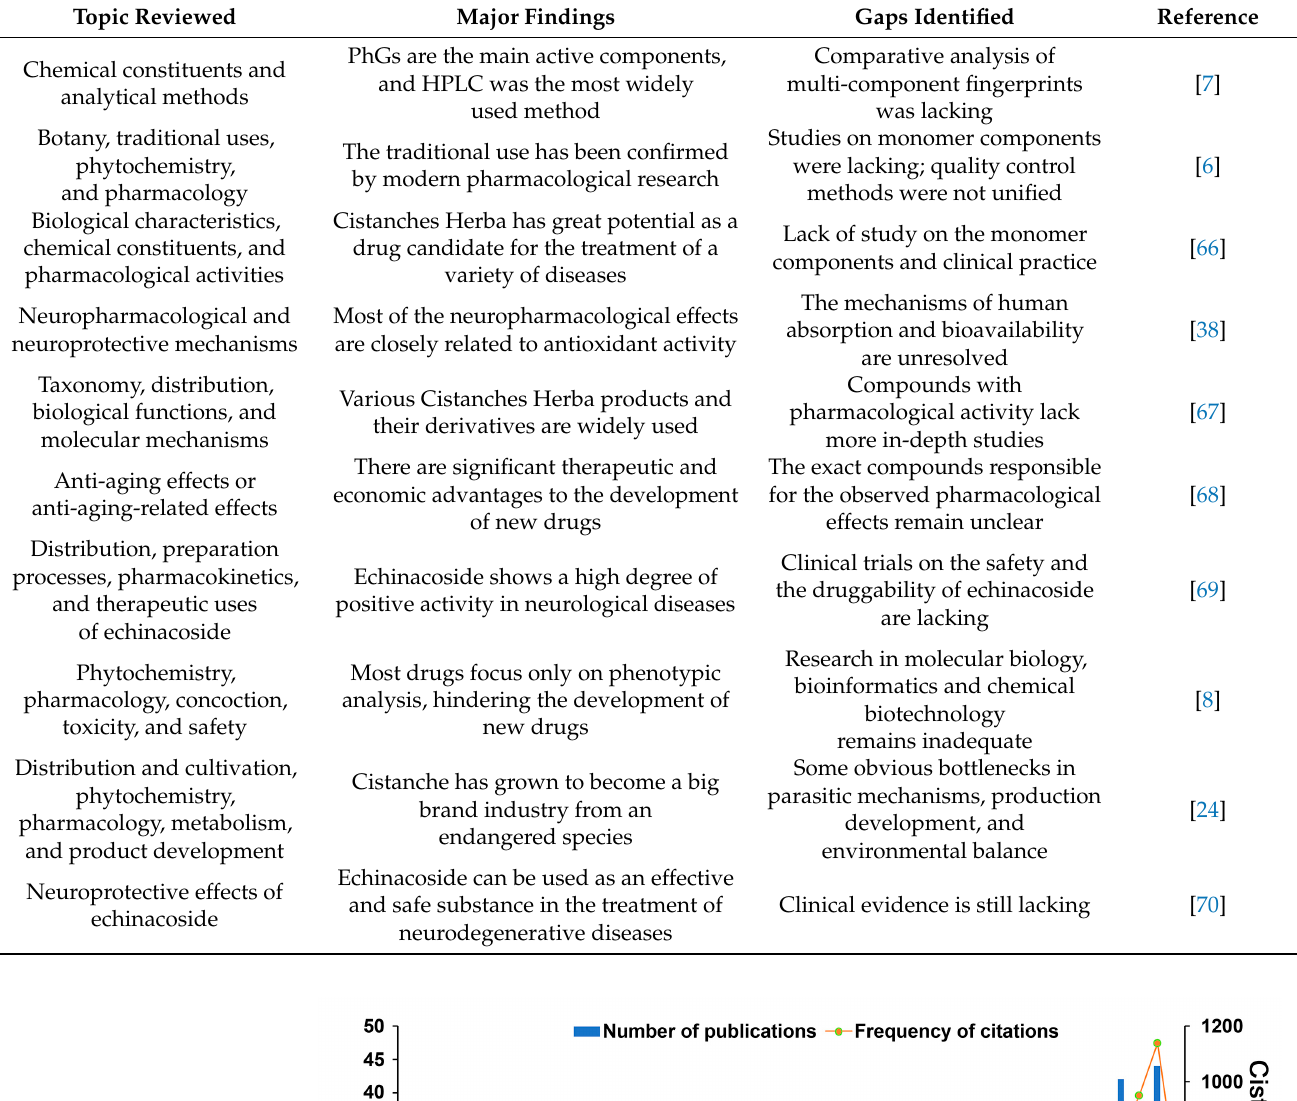
Table 2. Summary of major review articles published on Cistanche (1980–2022).